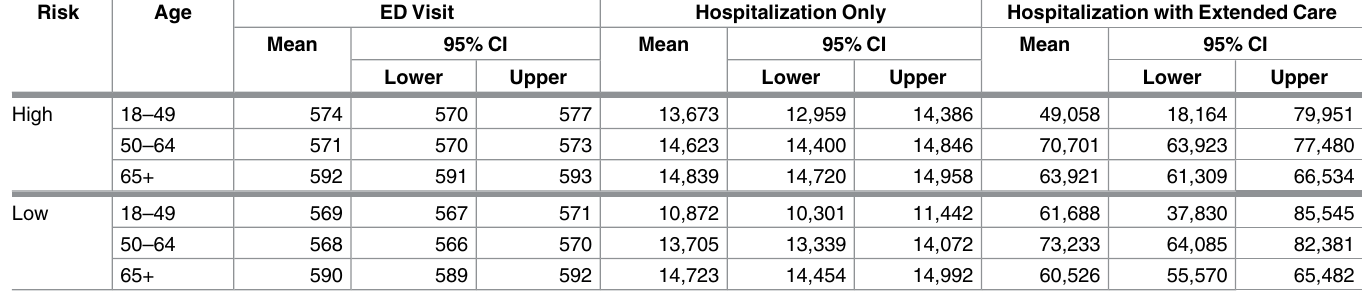
Table 6. Annual estimates of influenza-attributed direct medical costs for healthcare encounters by risk and age group in US Dollars averaged over five respiratoryseasons. Risk Age ED Visit